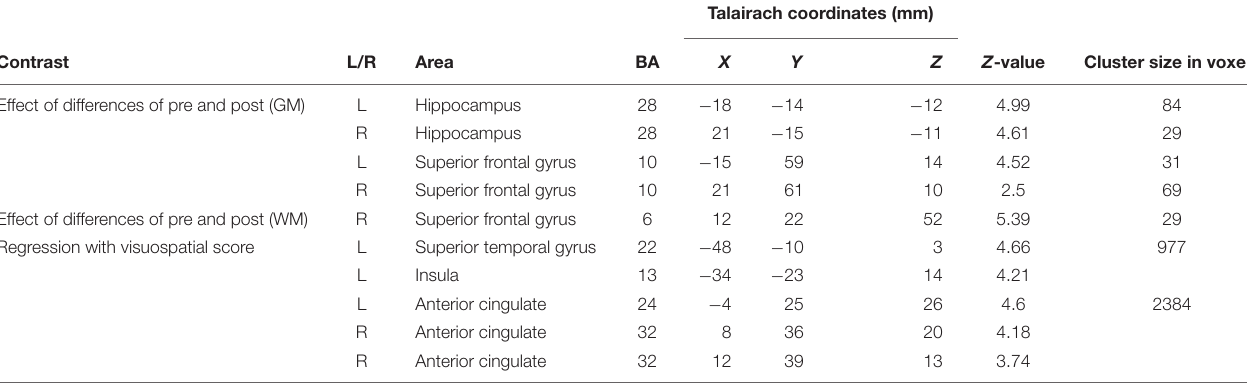
FIGURE 3 | Changes in gray matter volume in different brain areas after intervention. The axis of ordinate displays changes based on β parameter estimates (with 90% confidence intervals) of the peak voxels within the respective clusters. As a region of interest (ROI), we compared pre- and post-intervention contrasts between the three groups to eliminate the possibility of pre-intervention differences in GMV: (post_ExM > pre ExM) > (post_Cont > pre_Cont) and (post_Ex > pre_Ex) > (post_ Cont > pre_Cont). TABLE 4 | Cluster sizes, peak locations, and statistical values for each